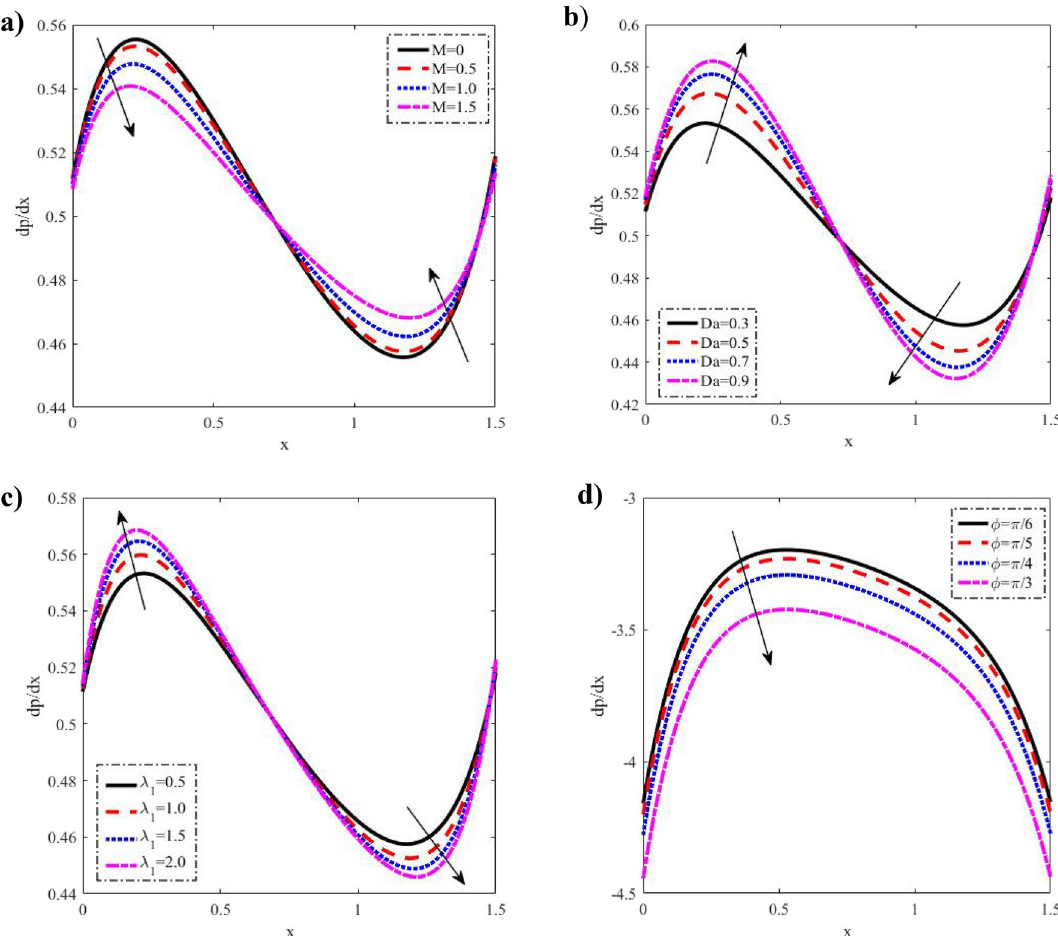
Figure 6. Discrepancies of the pressure gradient dp dx against the x -axis. ( a ) For different values of M . ( b ) For different values of Da . ( c ) For different values of (cid:31) 1 . ( d ) For different values of ϕ